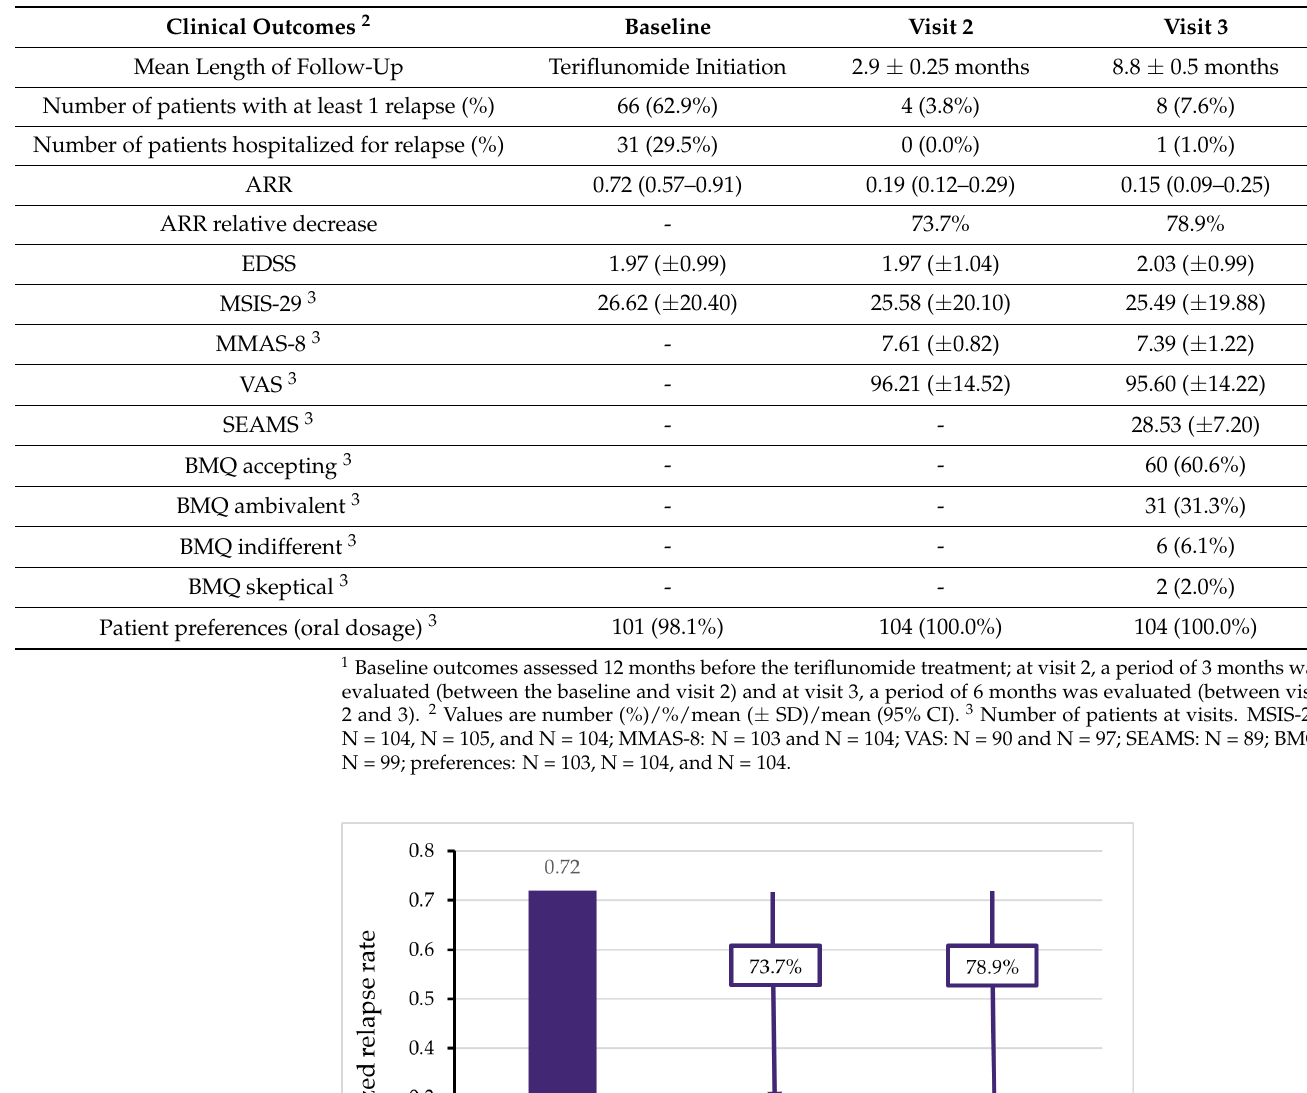
Table 3. Clinical and patient-reported outcomes after 3 and 9 months of teriflunomide therapy (N = 105) 1 .